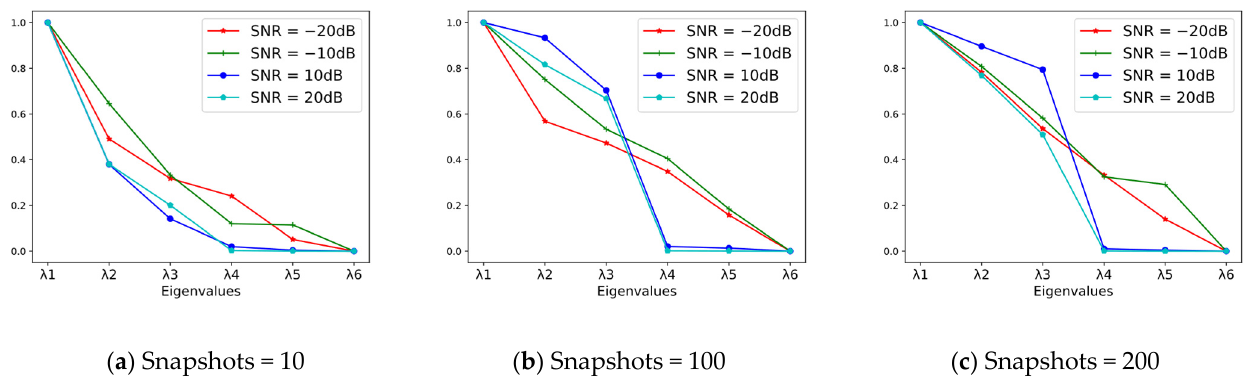
Table 1. Eigenvalues at different snapshots and SNR.